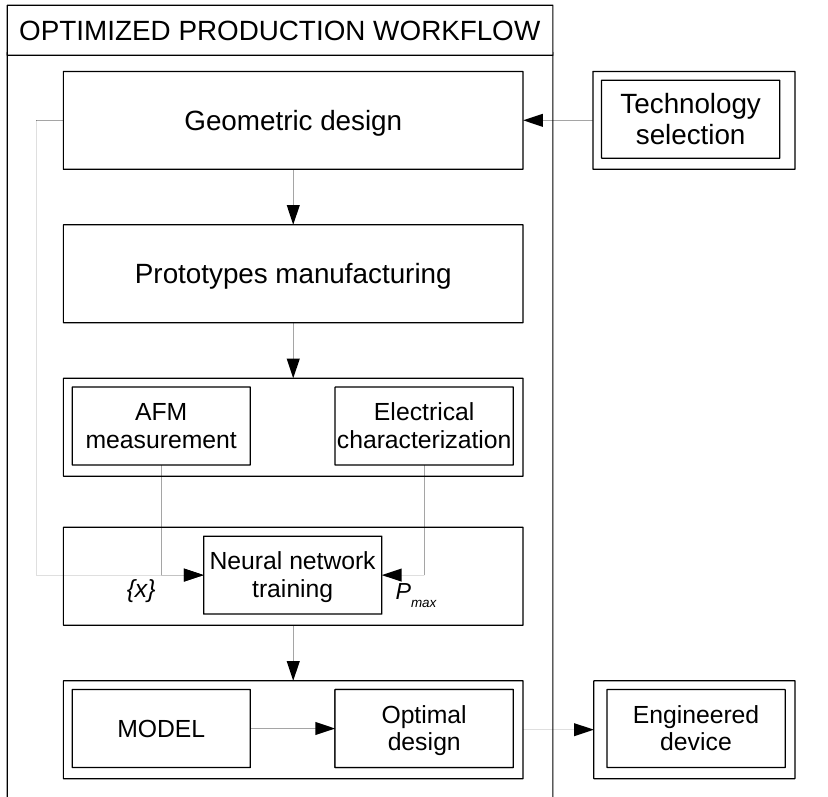
Figure 1. The proposed improvement to the production workflow of organic solar cells (OSCs): a neural network module is introduced in order to determine a model of the OSCs’ electrical characteristics in order to devise their optimal